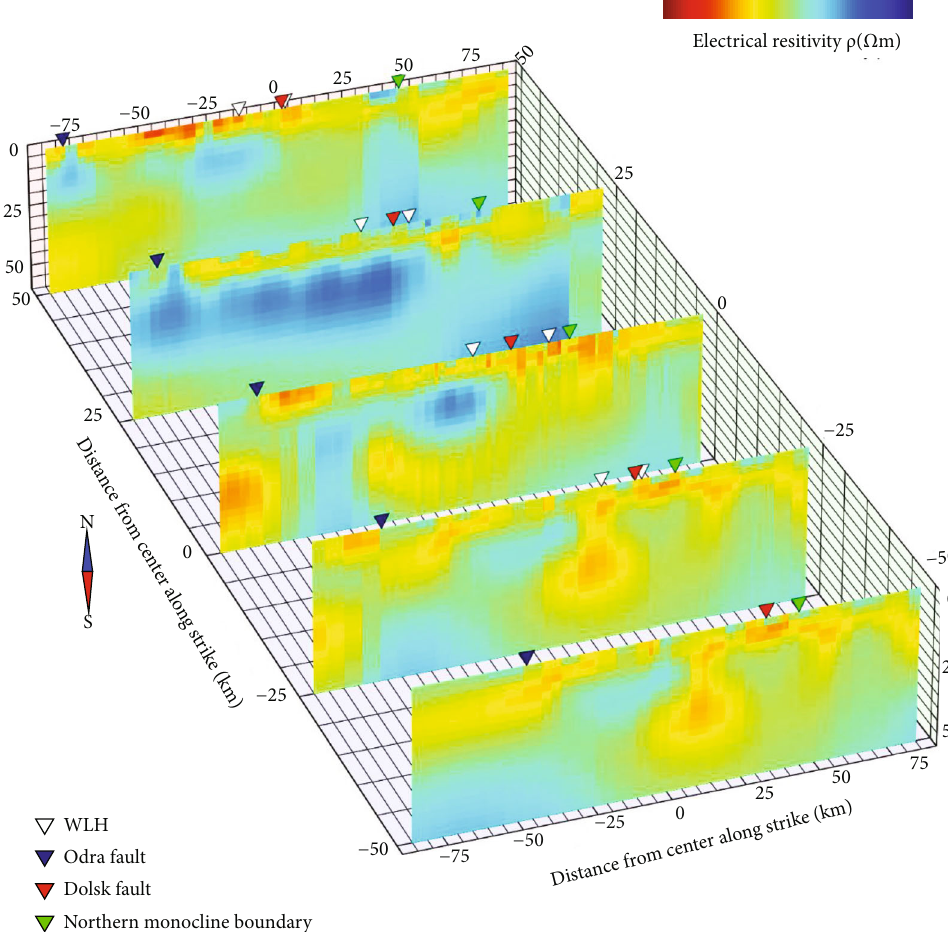
Figure 11: The presentation of 2D NLCG inversion results in the depth range from 0 to 50km on individual pro fi